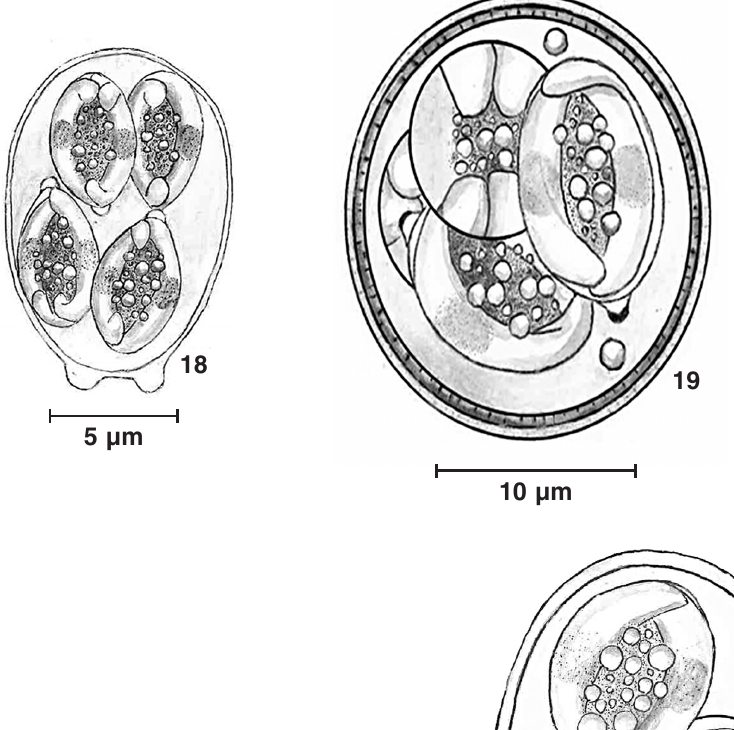
Figs 18-22. – Line drawings of mature oocysts from the faeces of Geochelone spp. Figs 18-20. Eimeria amazonensis n. sp., Eimeria carbonaria n. sp. and Eimeria carajasensis n. sp. all from Geochelone carbonaria. Figs 21 and 22. E. wellcomei n. sp., from Geochelone carbonaria and Isospora rodri- guesae n. sp. from Geochelone